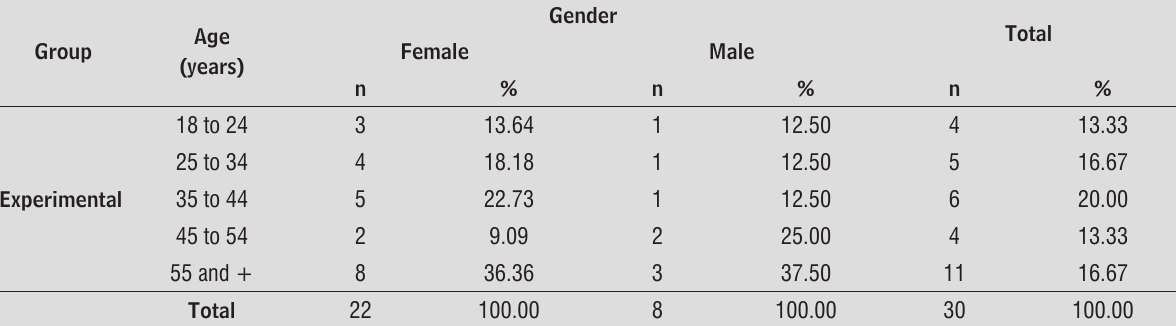
Table 1 - Distribution of the individuals with Temporomandibular Disorders, according to gender and age group in the group that received physical therapy and dental treatment, Ribeirão Preto - SP, 2008 Group